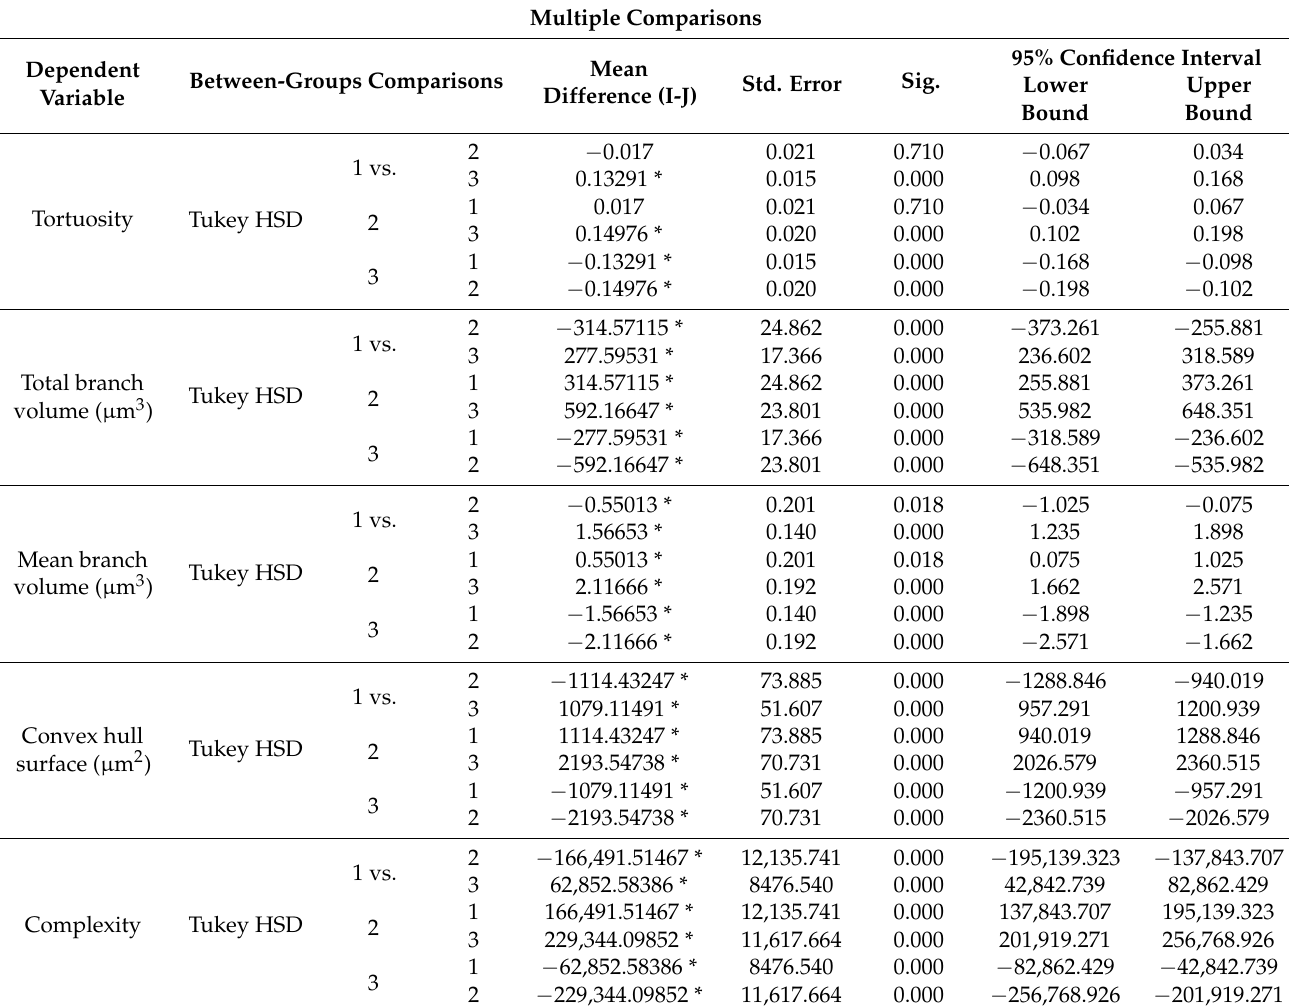
Table 4 shows the results after correction for multiple comparisons (Tukey’s HSD and Bonferroni) for the same morphometric variables. With the exception of tortuosity, all morphometric variables were significantly different between cluster 3 and clusters 1 and 2, distinguishing controls from infected animals and two groups of infected animals. Table 4. Values for morphometric variables of CA1/CA2 microglia, adjusted for multiple comparisons. Except for tortuosity, all morphometric variables differed significantly between cluster 3 (controls) and clusters 1 and 2 (infected